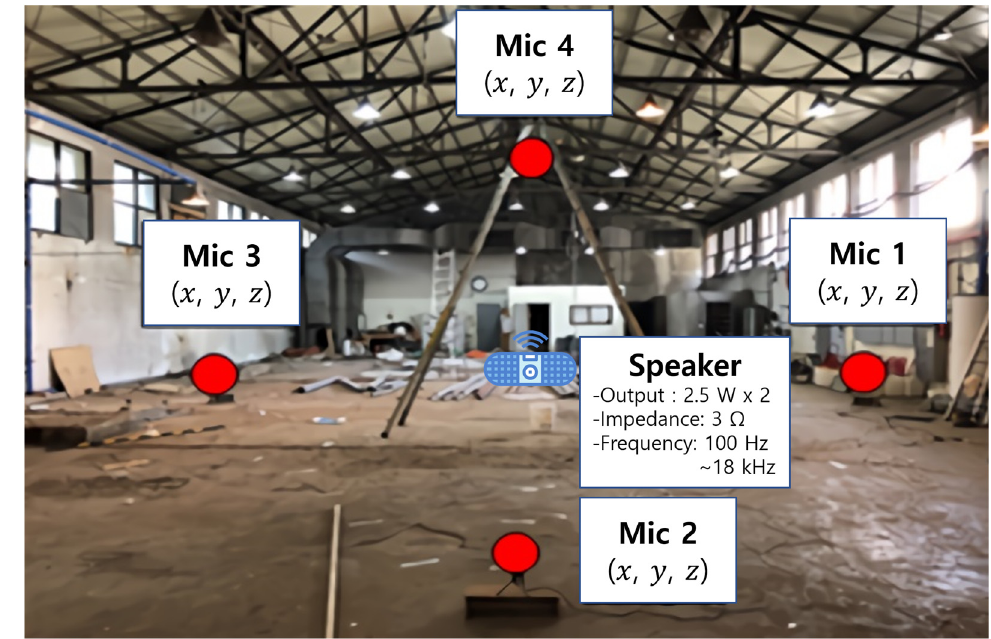
Figure 9. Construction site test environment.